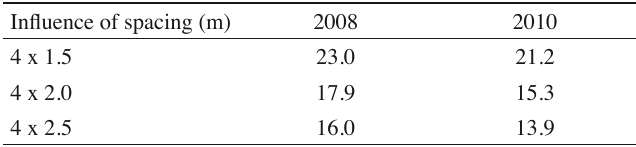
Table 11 - Calculated yield in 2008 and 2010